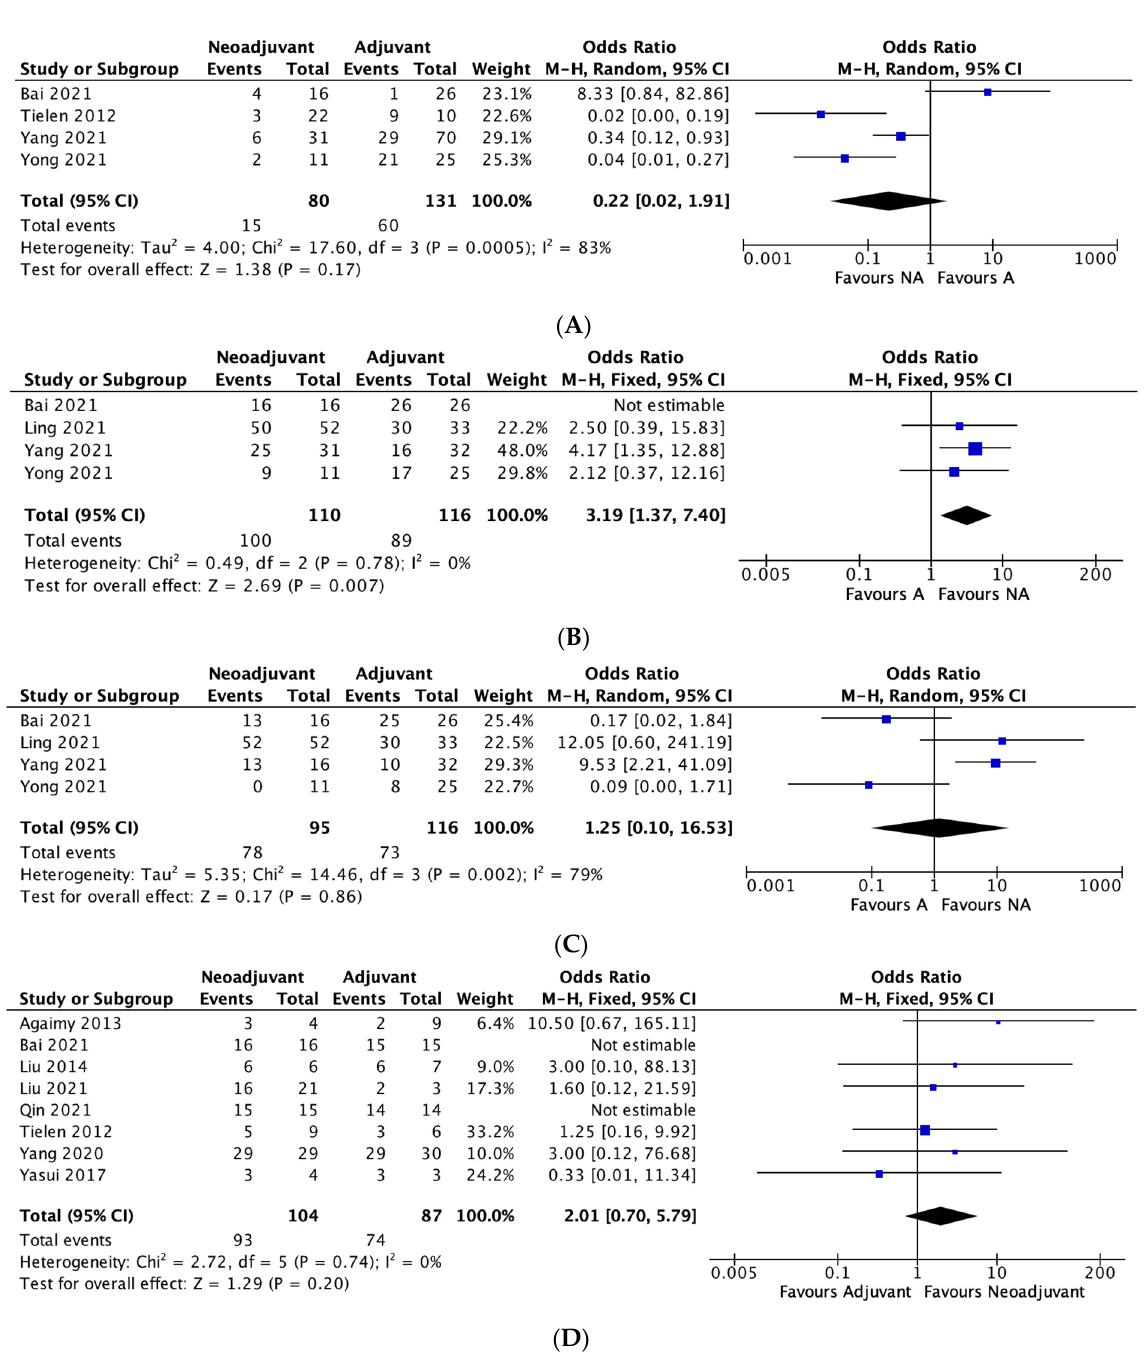
Figure 1. ( A – D ): Neoadjuvant vs. adjuvant chemotherapy meta-analysis outcomes. ( A ) Recurrence, ( B ) Five-year overall survival, ( C ) Five-year disease-free survival, ( D ) Negative margin (R0) rates.